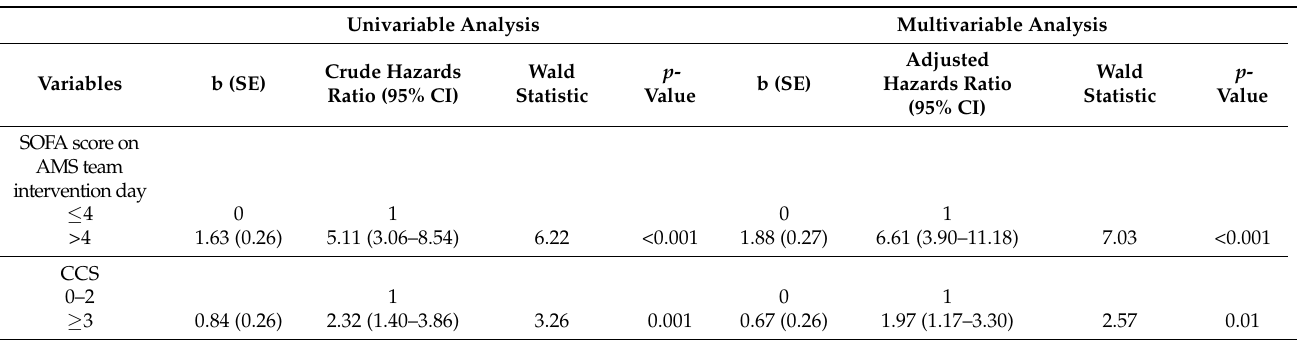
Table 8. Univariable and multivariable analysis of prognostic factor for 30-day all-cause mortality of patients with suspected bacterial infection on extended or restricted